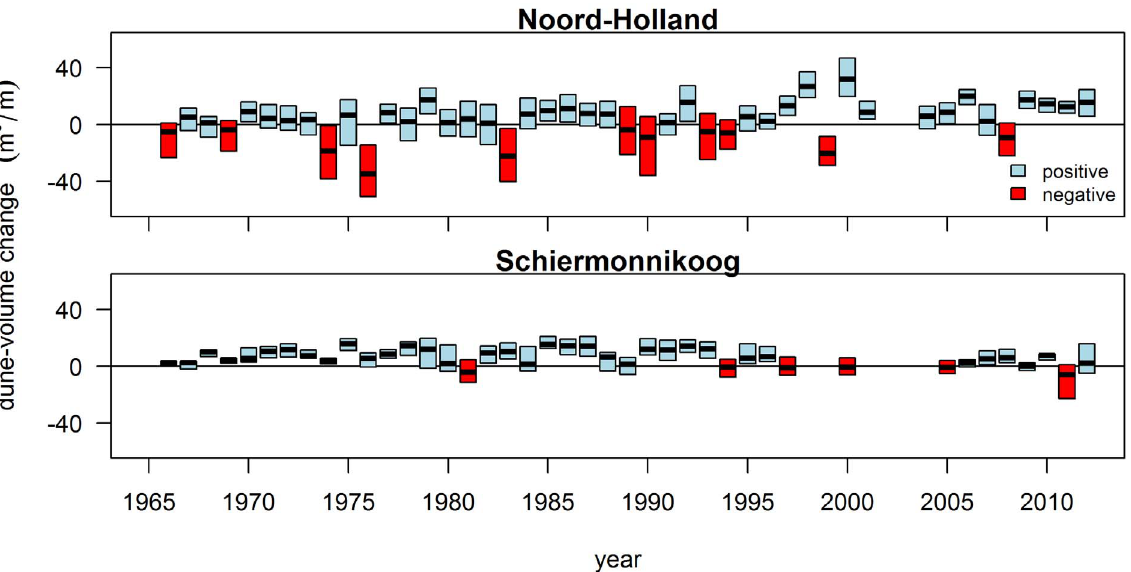
Figure 3. Temporal variability in dune-volume changes. Range of dune-volume changes ( D V) per year, calculated for Noord-Holland (top) and Schiermonnikoog (bottom). Each boxplot represents the upper and lower quartile and median of dune-volume changes for a single year. Differences among years indicate temporal variability in dune-volume changes. The height of the boxes indicates spatial variability in dune-volume changes. Boxes with a positive median are in blue, boxes with a negative median are in red.